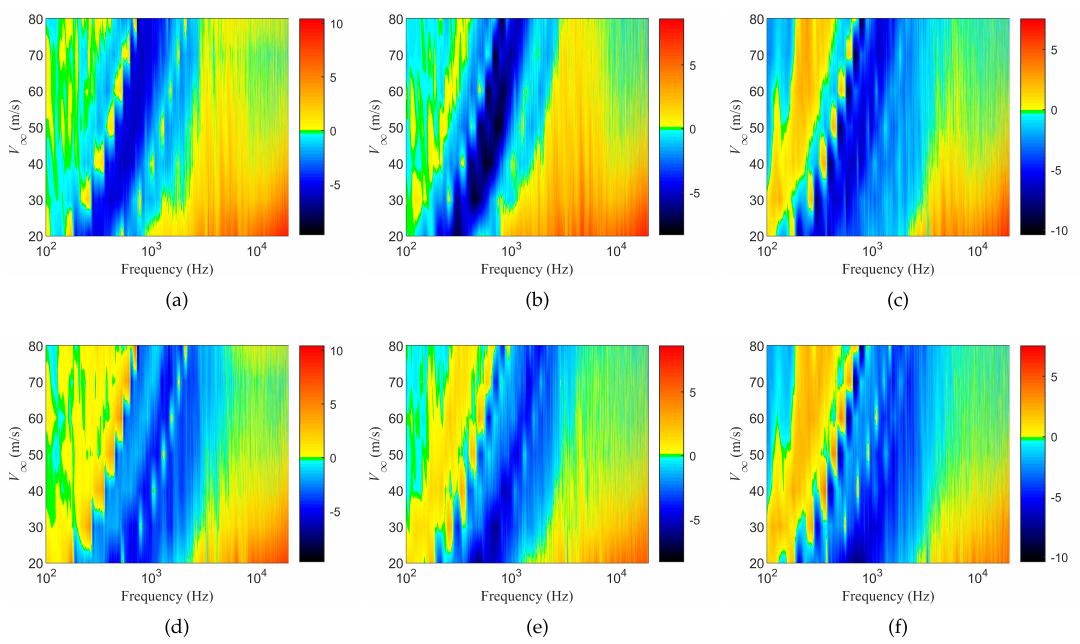
Figure 12. ∆ SPL as a function of frequency and flow velocity for different arrangements of the porous leading edges: ( a ) X80Y60Z40, L = 100 mm, α = 0 ◦ ; ( b ) X80Y60Z40, L = 200 mm, α = 0 ◦ ; ( c ) X80Y60Z40, L = 200 mm, α = 10 ◦ ; ( d ) X40Y60Z80, L = 100 mm, α = 0 ◦ ; ( e ) X40Y60Z80, L = 200 mm, α = 0 ◦ ; and ( f ) X40Y60Z80, L = 200 mm, α = 10 ◦ .